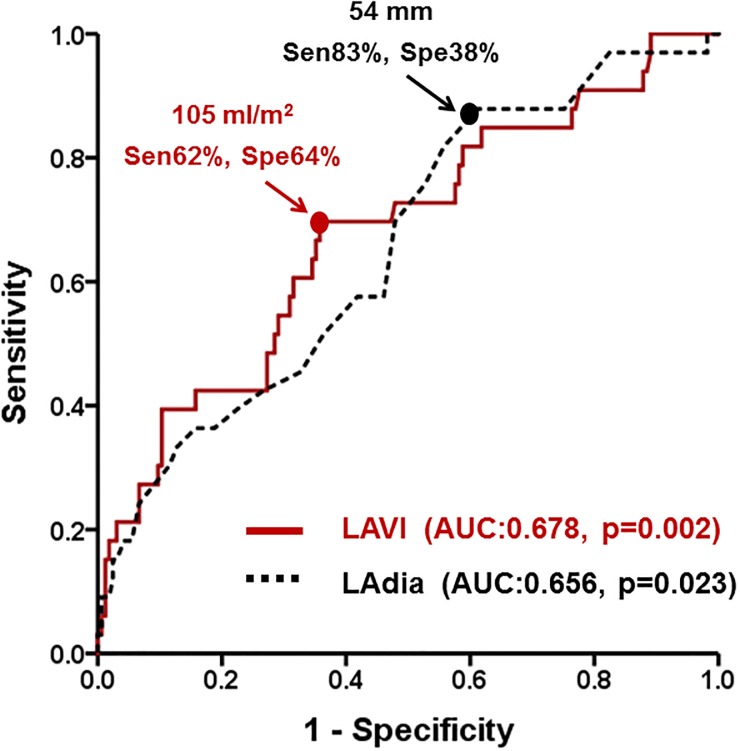
Performances of LAVI and LAdia for prediction of SND.